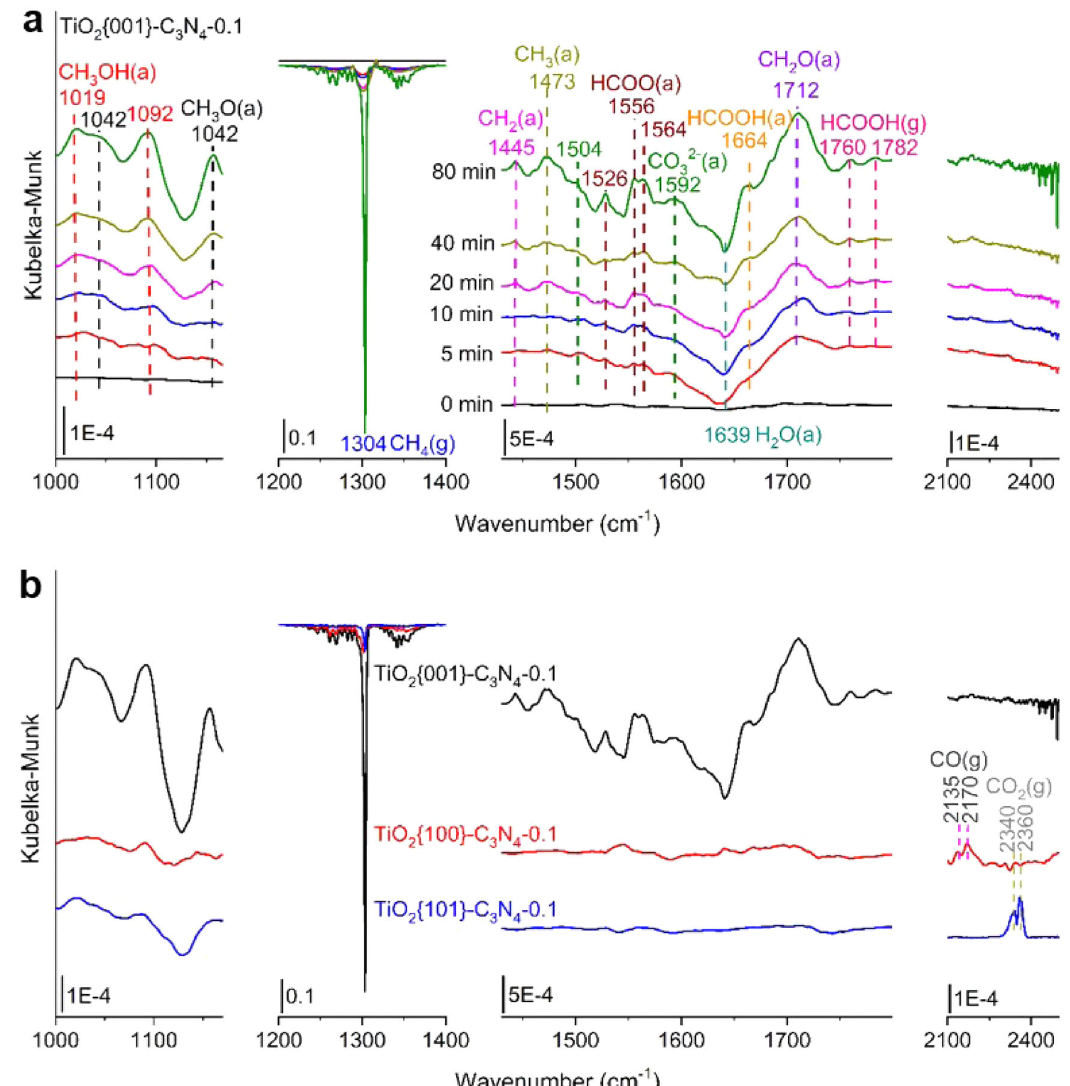
Fig. 4 | In situ characterization. a In situ DRIFTS spectra of photocatalytic CH 4 conversionat298KunderdifferentlightirradiationtimesoverTiO 2 {001}-C 3 N 4 − 0.1 with DRIFTS spectra prior to UV light illumination as the background spectra. b In situ DRIFTS spectra of photocatalytic CH 4 conversion at 298K under